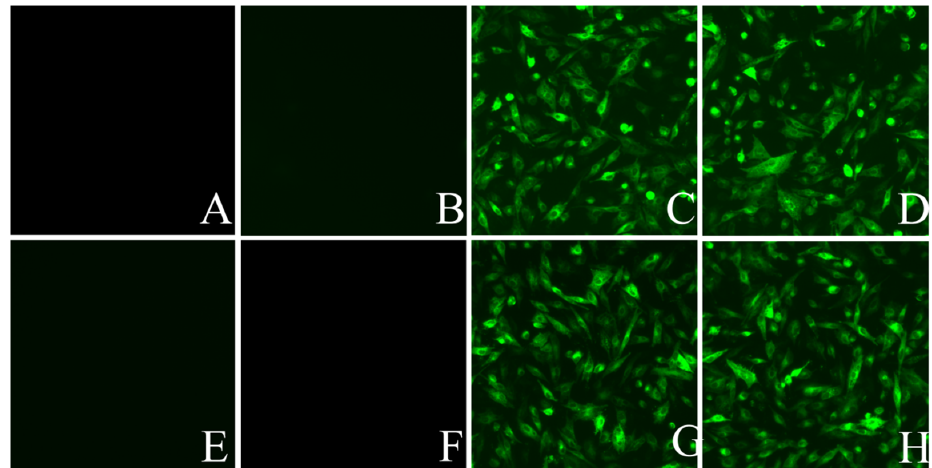
Figure 6. Indirect immunofluorescence assay (400×), ( A ) DF-1 cells transfected with psi-flag plasmid. ( B ) DF-1 cells transfected with psi-flag-STAT3 plasmid. ( C ) DF-1 cells transfected with psi-flag plasmid and infection with ALV-A rHB2015012. ( D ) DF-1 cells transfected with psi-flag-STAT3 plasmid and infection with ALV-A rHB2015012. ( E ) DF-1 cells transfected with pLKO.1-GFP plasmid. ( F ) DF-1 cells transfected with pLKO.1-STAT3 plasmid cells. ( G ) DF-1 cells transfected with pLKO.1-GFP plasmid and infection with ALV-A rHB2015012. ( H ) DF-1 cells transfected with pLKO.1-STAT3 plasmid and infection with ALV-A rHB2015012.